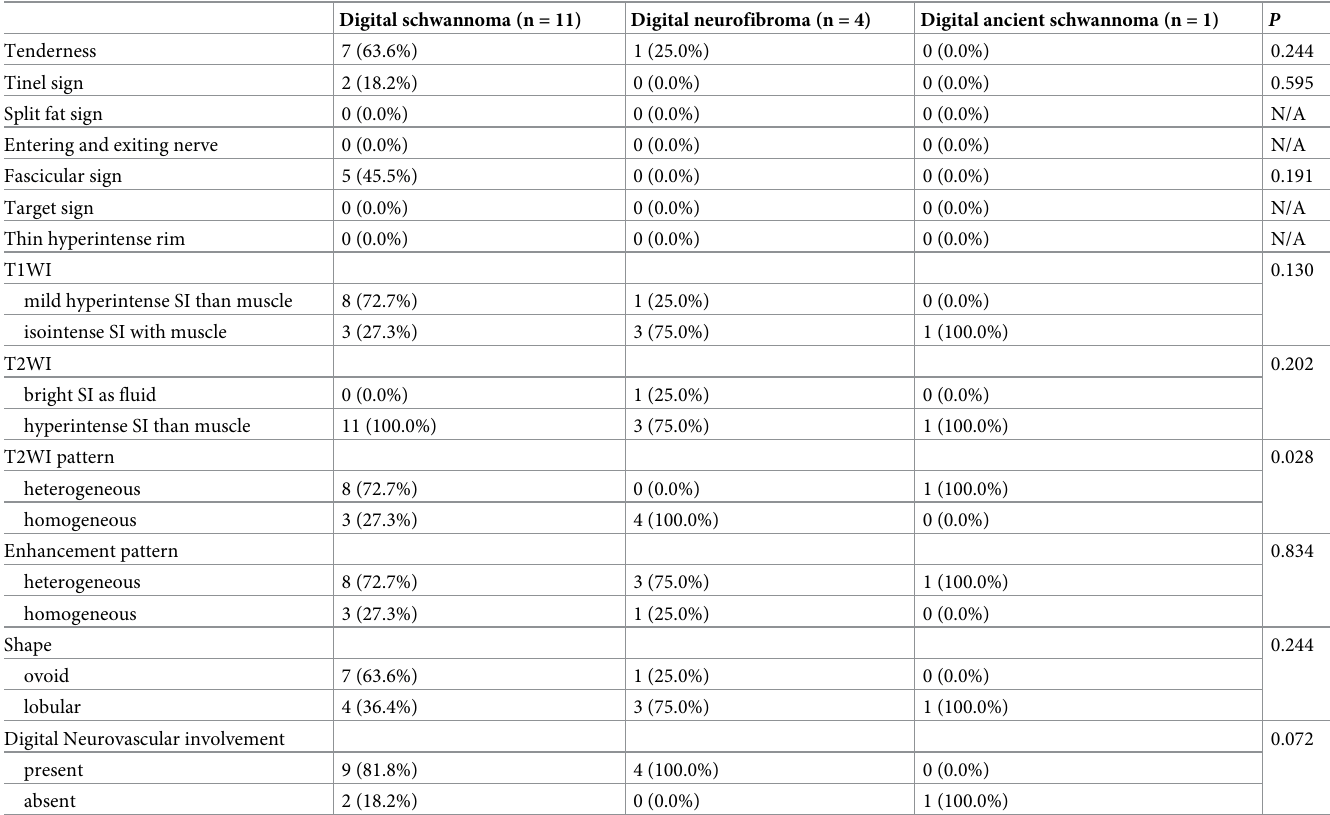
Table 4. Comparison of clinical and MRI findings between digital PNST